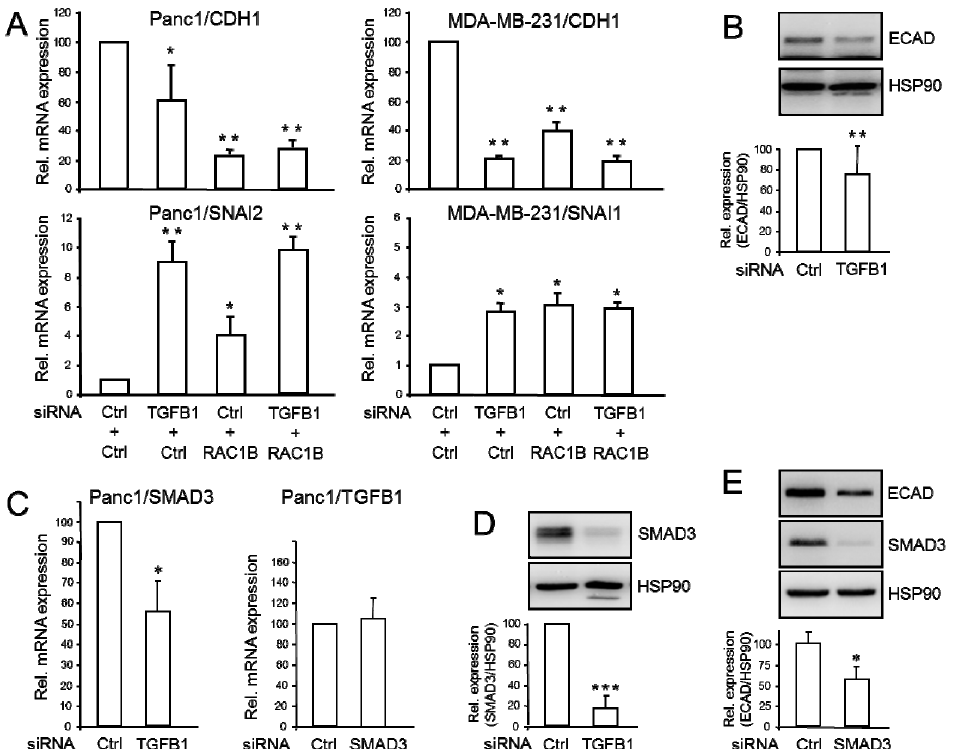
Figure 4. E ff ects of siRNA-mediated inhibition of TGF β 1 or RAC1B on genes involved in EMT and cell motility. ( A ) Panc1 or MDA-MB-231 cells were transiently transfected twice with 50 nM of either ctrl siRNA, TGF β 1 siRNA, RAC1B siRNA, or a combination of both, as indicated. Forty-eight h later, cells were processed for qPCR analysis of CDH1 and SNAI1 , and GAPDH as an internal control. ( B ) Panc1 TGFB1KD cells were subjected to immunoblot analysis of ECAD, SNAIL, RAC1B, and HSP90 as a loading control. ( C ) As in ( A ), except that Panc1 TGFB1KD cells were subjected to amplification of SMAD3 mRNA and Panc1 SMAD3KD cells subjected to amplification of TGF β 1 mRNA. ( D ) Immunoblot analysis of SMAD3 in Panc1 TGFB1KD cells. ( E ) Immunoblot analysis of ECAD in Panc1 SMAD3KD cells. Data in ( A , C ) represent the mean ± SD of GOI after normalization with the housekeeping genes (TBP or GAPDH) from three independent transfection experiments. The graphs below the blots in panels ( B , D , E ) depict data quantification based on densitometric readings from band intensities after normalization with those for HSP90 (mean ± SD; B , D : n = 5, E : n = 4). The asterisks indicate significant di ff erences (* p < 0.05; ** p < 0.01; *** p <